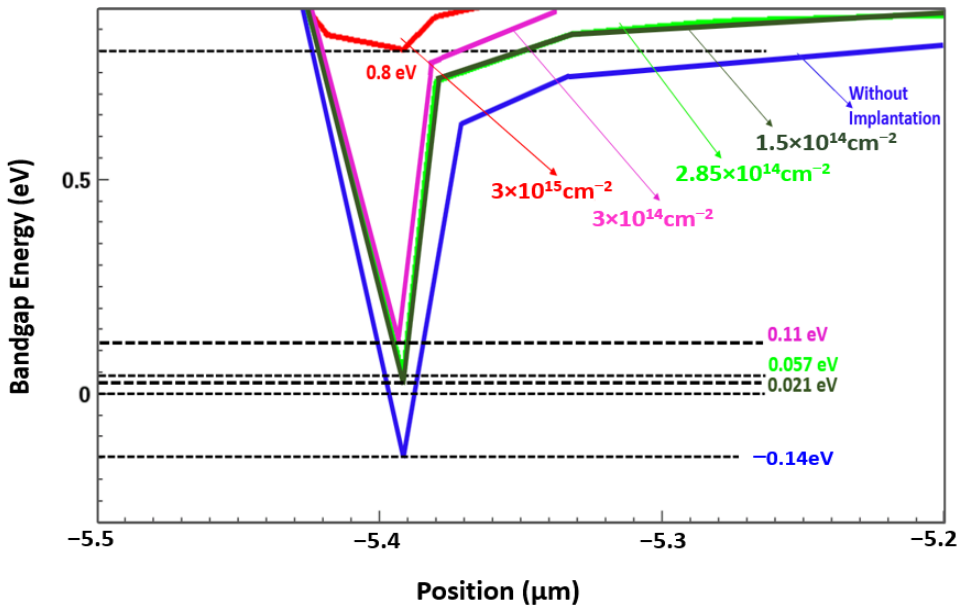
Figure 4. Bandgap analysis of AlGaN/GaN with nitrogen ion implanted gate HEMT.